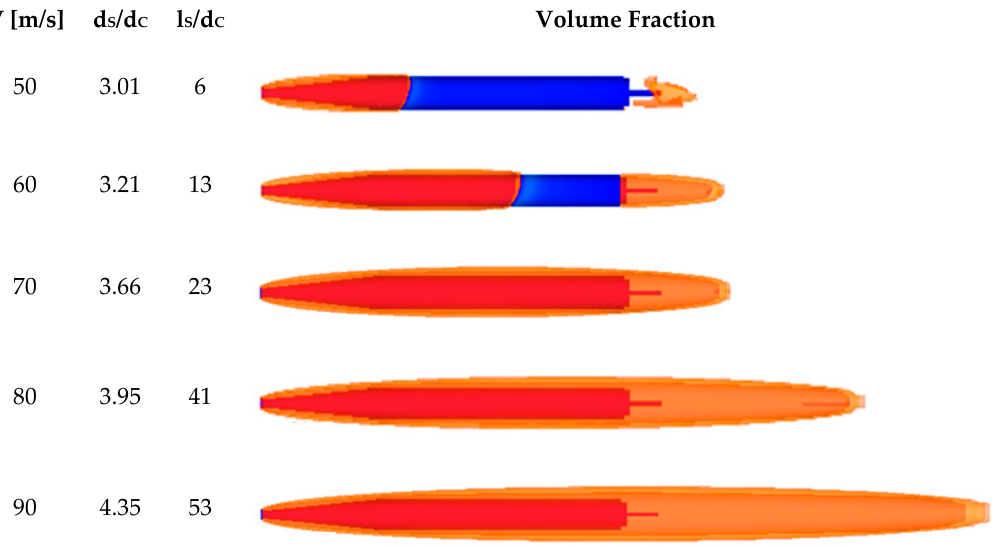
Figure 16. Prediction of supercavitation shape according to velocity change.